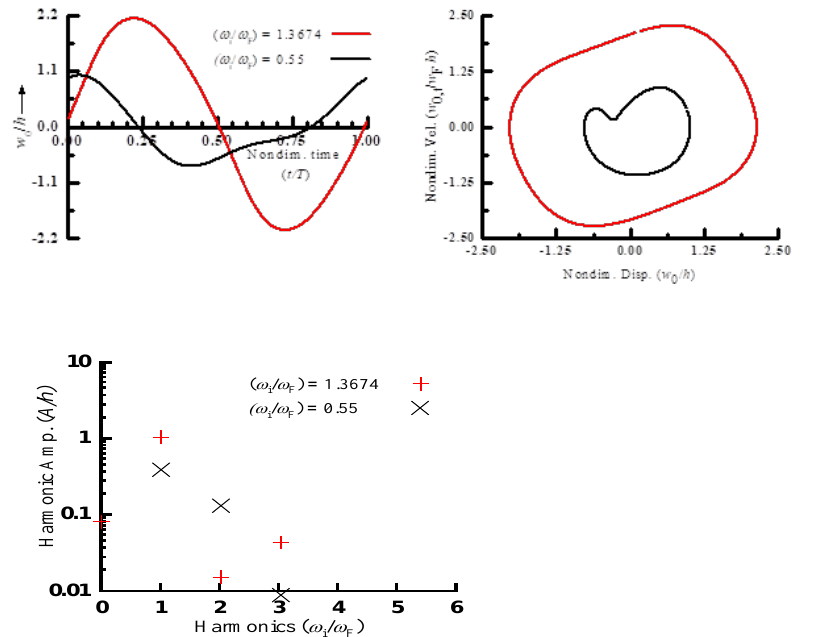
Figure 13. Response history, phase plane plots, and Fast Fourier Transform (FFT) corresponding to peaks amplitude in Figure 12.